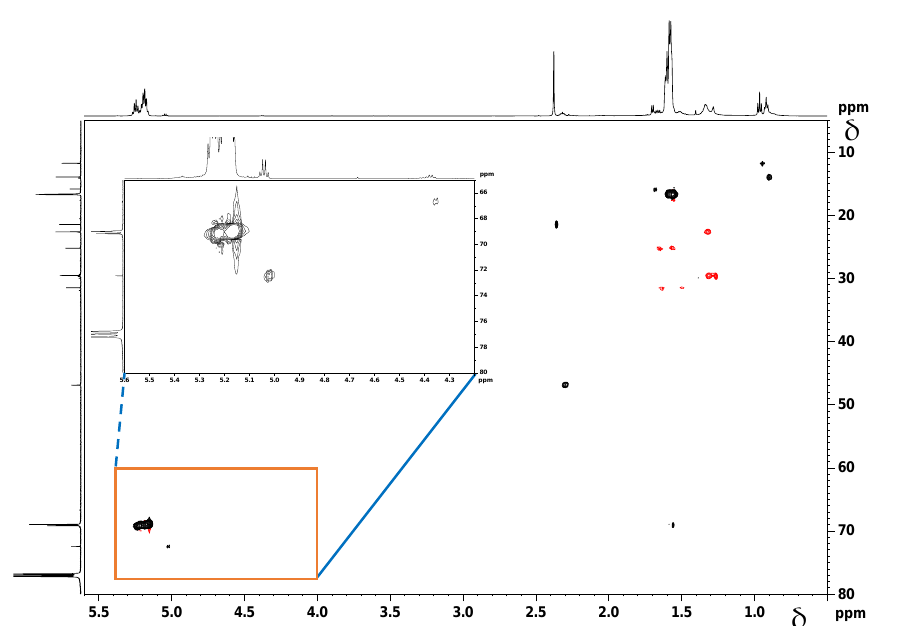
tum Correlation (DEPT-HSQC) spectrum of the cyclooctanol-PDLLA homopolymer.